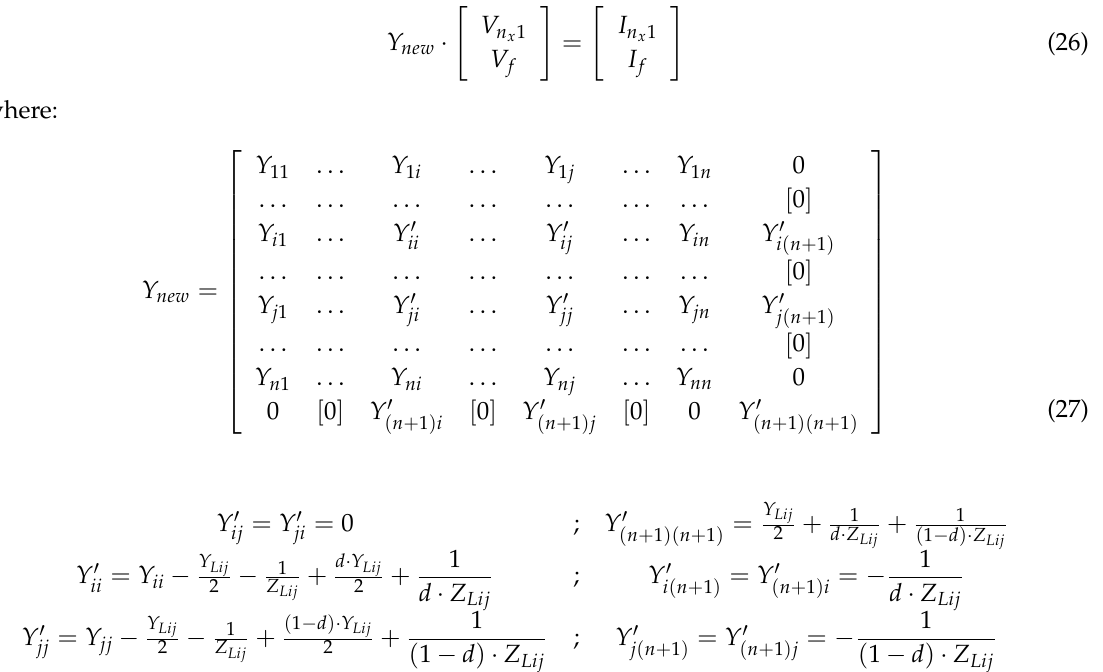
Figure 7. Simplified model of section in the Jiang et al. method